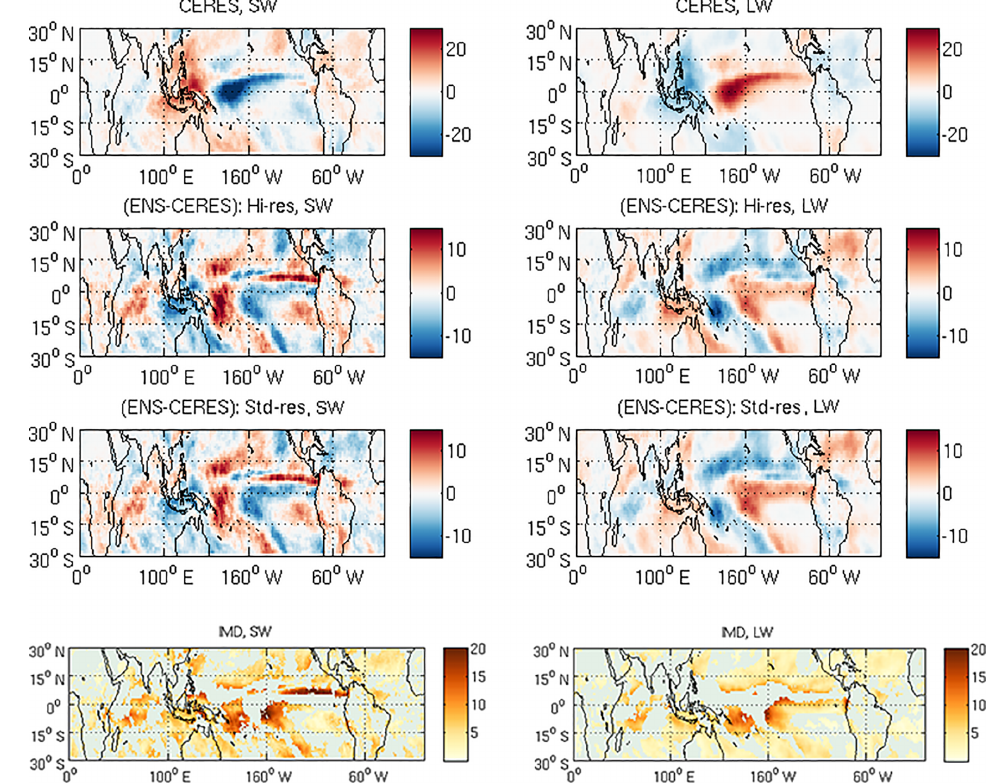
Figure 5. The SW (left) and LW (right) cloud radiative fluxes at the TOA as a response to positive phase of ENSO (ENP) from the top row: CERES-EBAF observations; second row: the ensemble mean Hi-res; and third row: Std-res model-simulated differences of this response from observations. Bottom row: the ensemble intermodel differences in Wm − 2 . The grey shaded areas are the regions where all the nine model setups do not agree with the sign of the